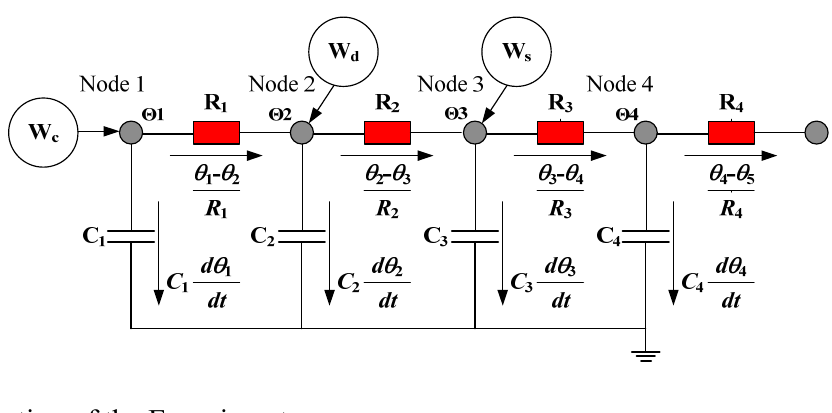
Figure 12. Equivalent circuit of the cable thermal circuit model.